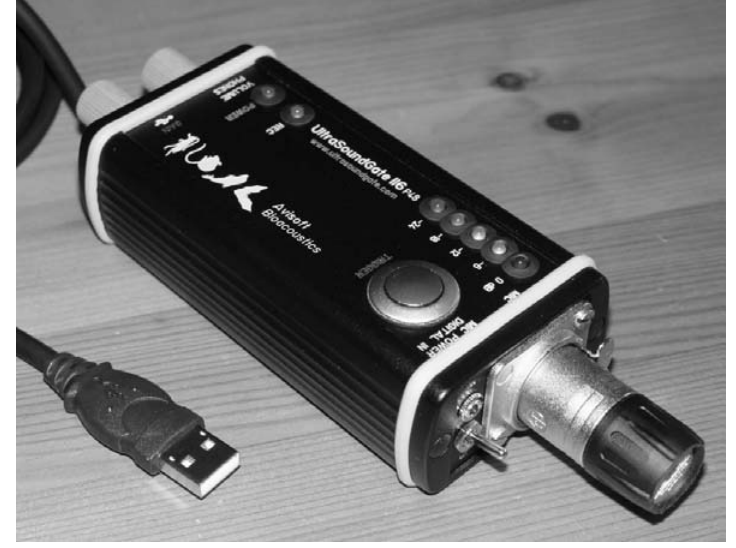
Fig. 1 – UltraSoundGate 116.